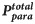
Mechanistic overview showing the three modeled parallel permeability pathways in three different colors (red, blue and green) as well as the serial particular permeabilities they comprise.The paracellular permeation pathway,Pparatotal, is shown in red and is comprised of PUWL(apical), Ppara, Pfilter and PUWL(basal); the lateral permeation pathway, Plateraltotal, is shown in blue and is comprised of PUWL(apical), Plateral, Pfilter and PUWL(basal);, and finally the cytosolic permeation pathway, Pcytosoltotal, is shown in green and is comprised of PUWL(apical), Pm, Pcytosol, Pm, Pfilter and PUWL(basal).